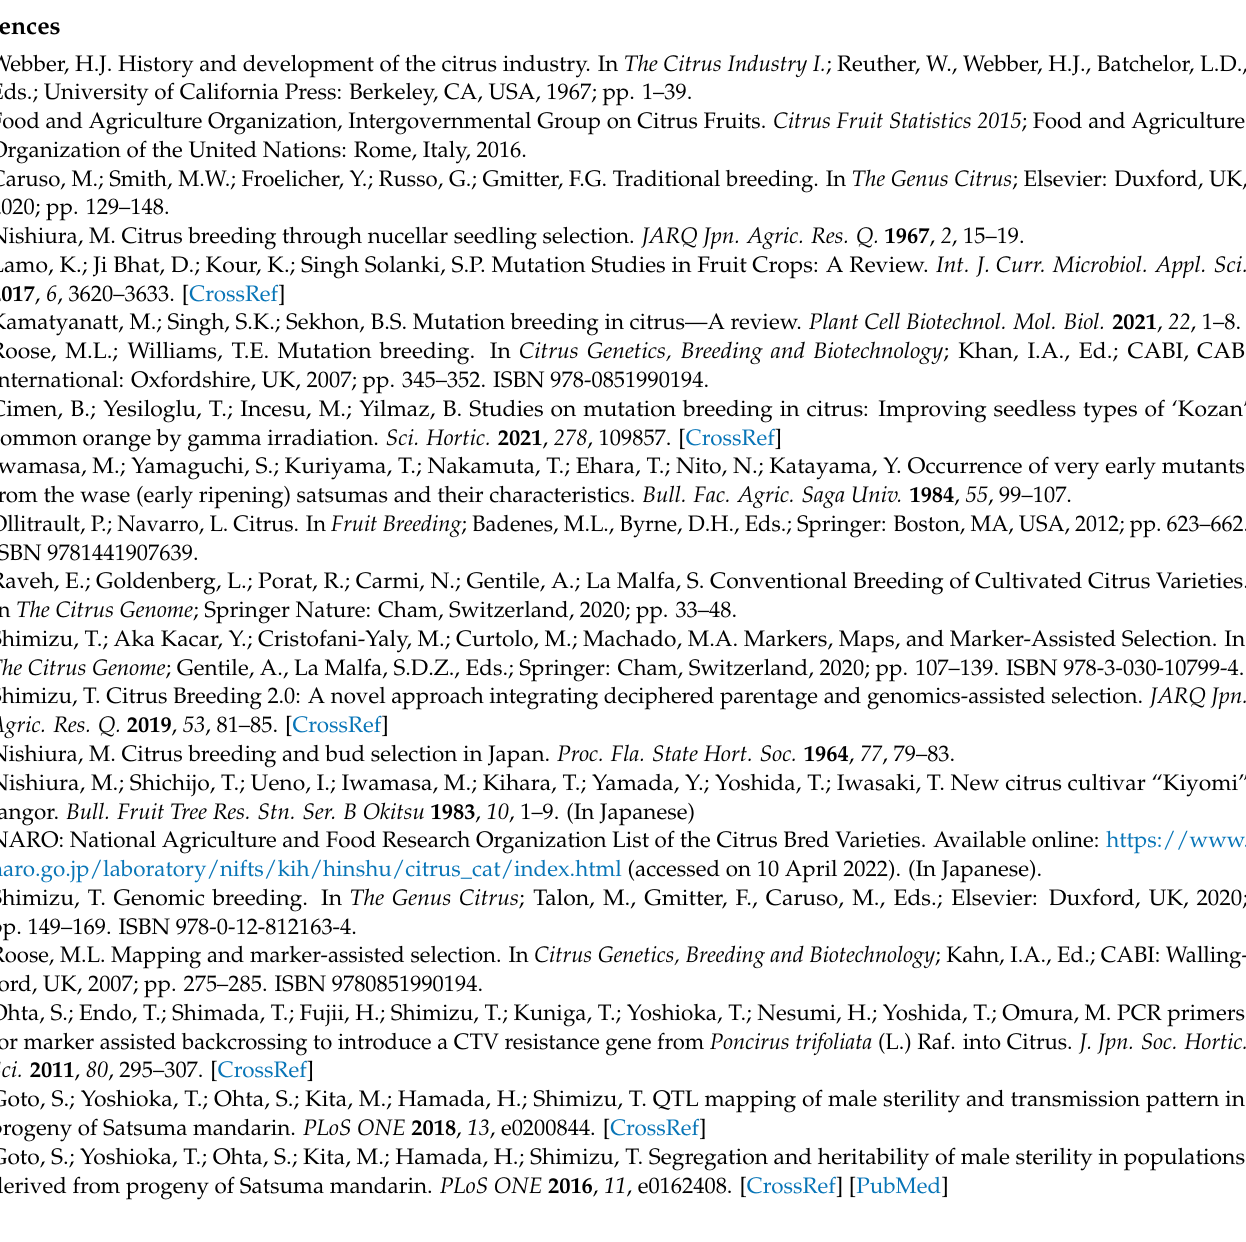
Figure S4: Fruit cross-section of Kaikoukan with their offspring cultivars, Figure S5: Fruit cross-section of three tachibana strains with their offspring